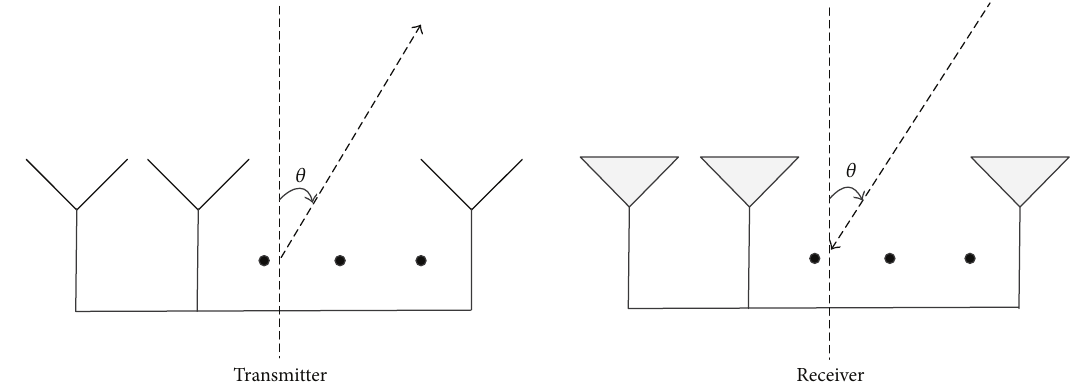
Figure 1: Signal model of collocated MIMO